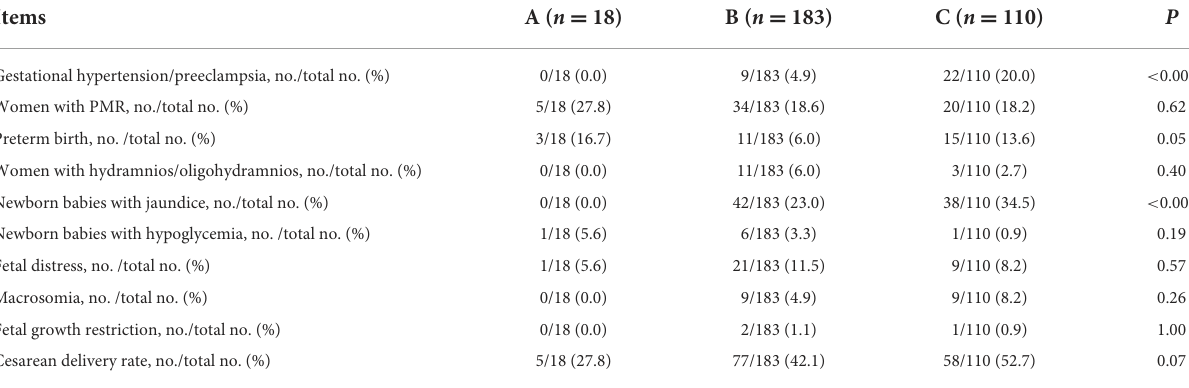
TABLE 3 Comparison of pregnancy outcomes among the three groups (X ± S).